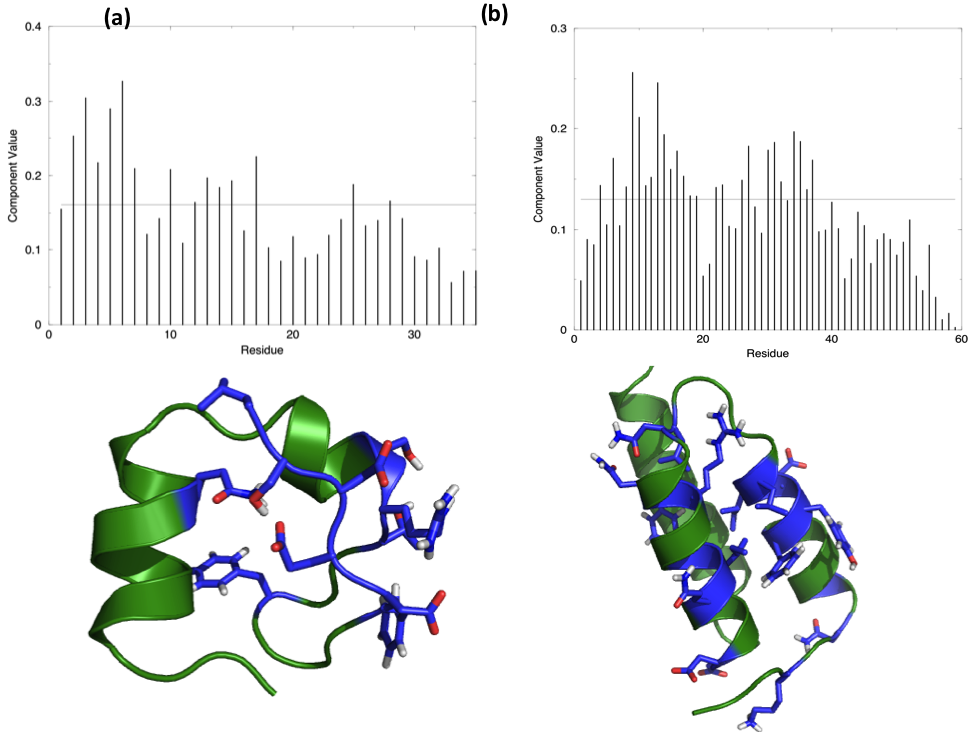
Figure 1. Representation of the components of the main eigenvector and projection of the identified hot spots on the 3D structure of the two simulated proteins: ( a ) HP35; ( b ) Protein A. The hot spots are evidenced in stick representation and blue